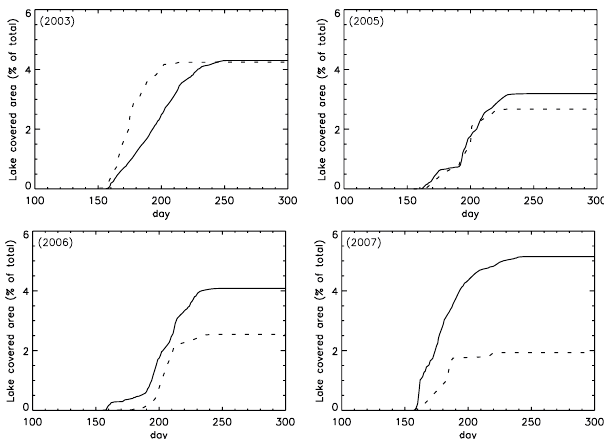
Fig. 7. Multi-year comparison of cumulative lake area (1100m to 1700ma.s.l.) as a percentage of total area. Modelled values are given with solid lines and observed values are given